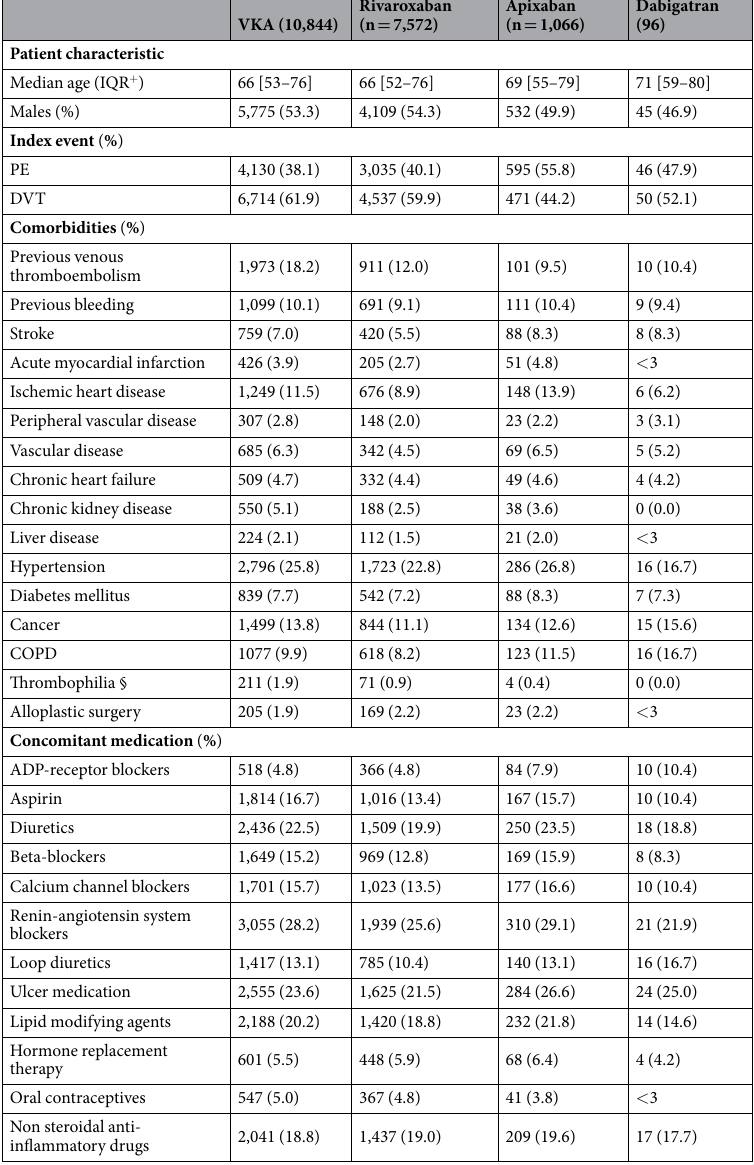
Table 1. Table of patient characteristics in apixaban, dabigatran, VKA and rivaroxaban groups. + IQR = Interquartile Range. § Thrombophilia (factor v Leiden, prothrombin mutation, protein C, S,